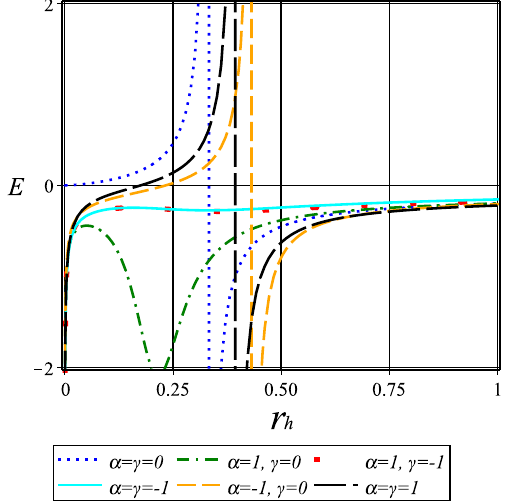
Fig. 8 Internal energy of LMP solution in hyperbolic space in terms of the black hole horizon for l = 1 and a = 10